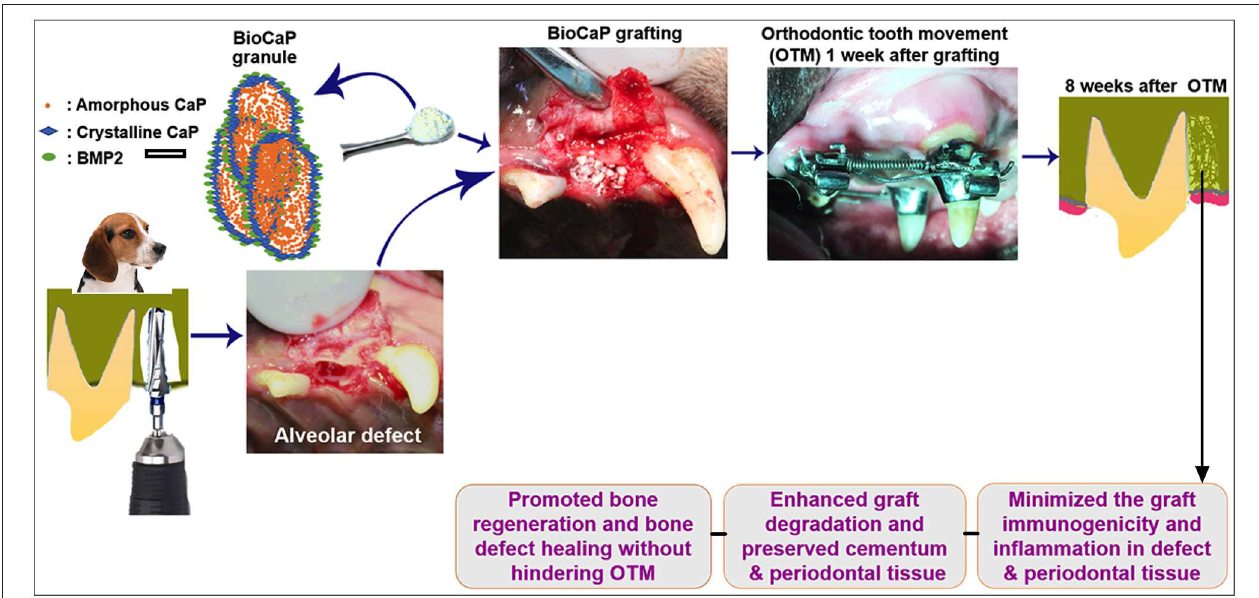
FIGURE 8 | Scheme illustrating the procedure and main findings of this